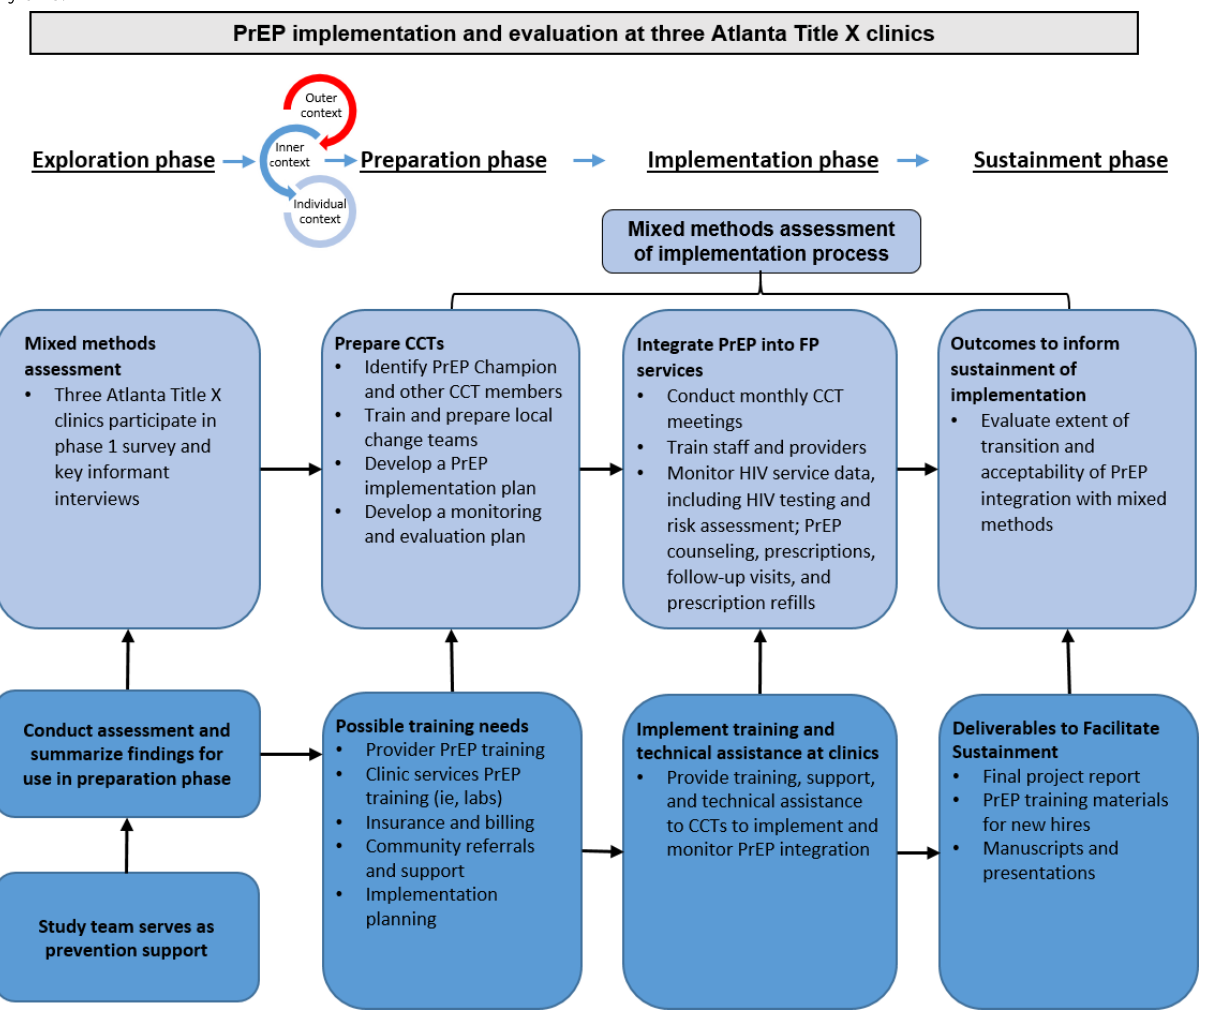
Figure 1. Pre-exposure prophylaxis implementation and evaluation process at three Atlanta Title X clinics including a federally qualified health center clinic, specialized family planning clinic, and hospital-based family planning clinic. CCT: Clinic Change Team; FP: family planning; PrEP: pre-exposure